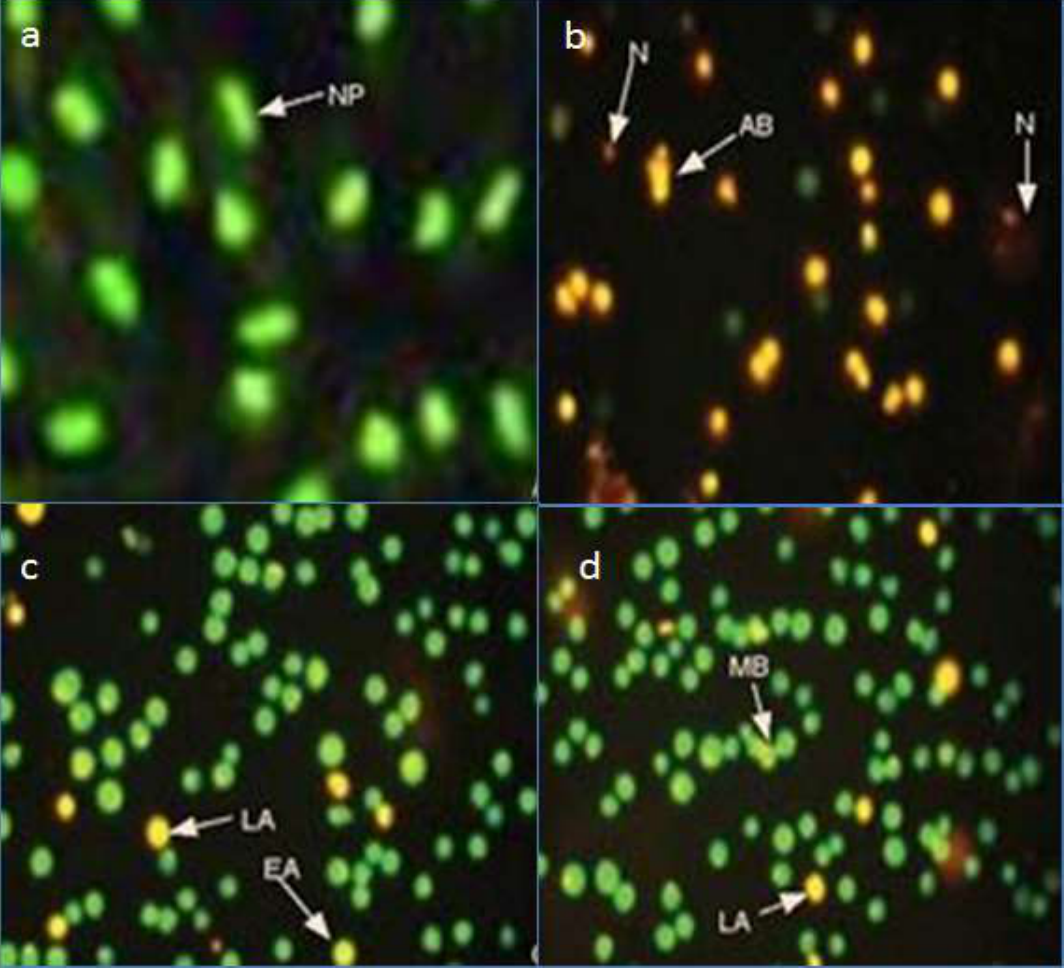
Figure 6. Images taken with fluorescent microscope: ( a ) untreated leishmania promastigotes and treated with ( b ) quercetin, ( c ) gallic acid, and ( d ) rutin. AB: apoptotic body, LA: late apoptosis, EA: early apoptosis, MB: membrane blebbing, N: necrosis, and NP: normal